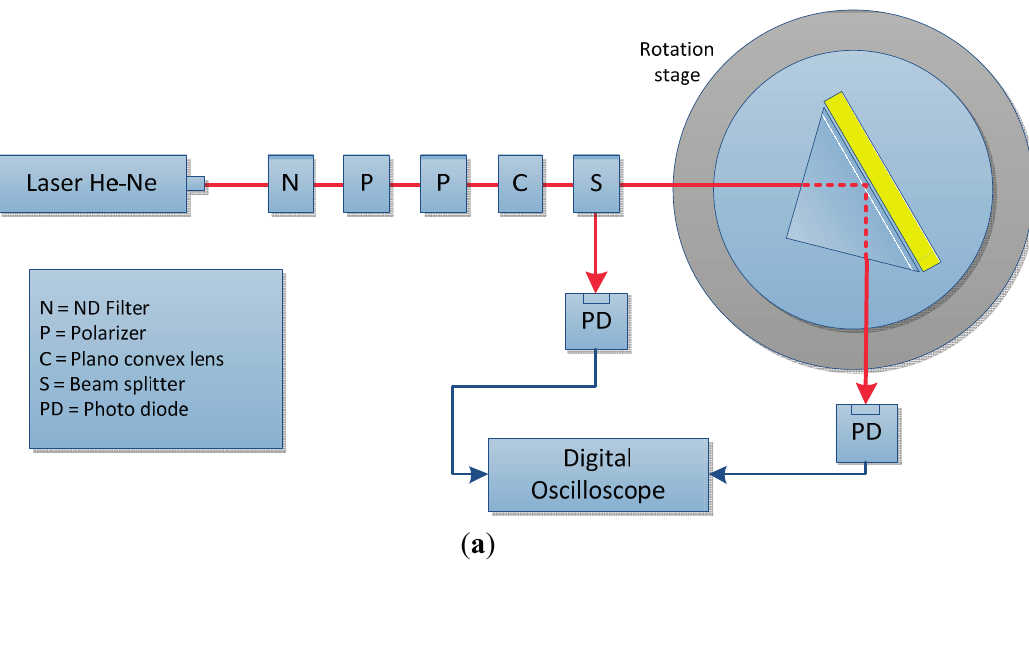
Figure 2. ( a ) Experimental setup for an angular interrogation SPR sensing system; ( b ) Experimental setup for wavelength